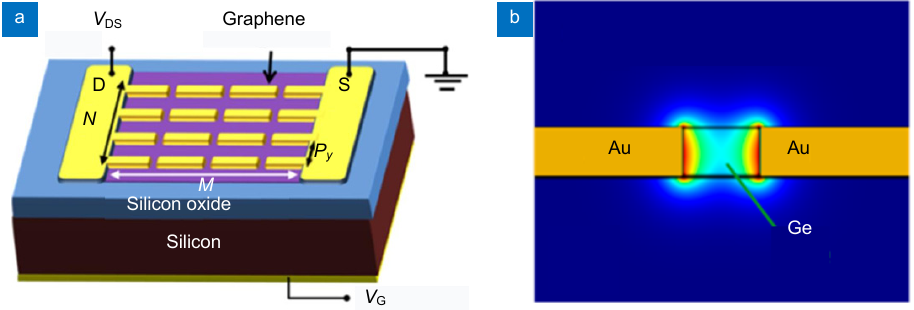
Fig. 7 | Schematic diagrams of plasmonic photoconductive detectors . ( a ) Antenna assisted graphene detector. ( b ) MSM plasmonic waveguide with Ge as absorber and Au as plasmonic cladding. Figures reproduced from: (a) ref. 46 , American Chemical Society; (b) ref. 48 , Amer- ican Chemical Society.